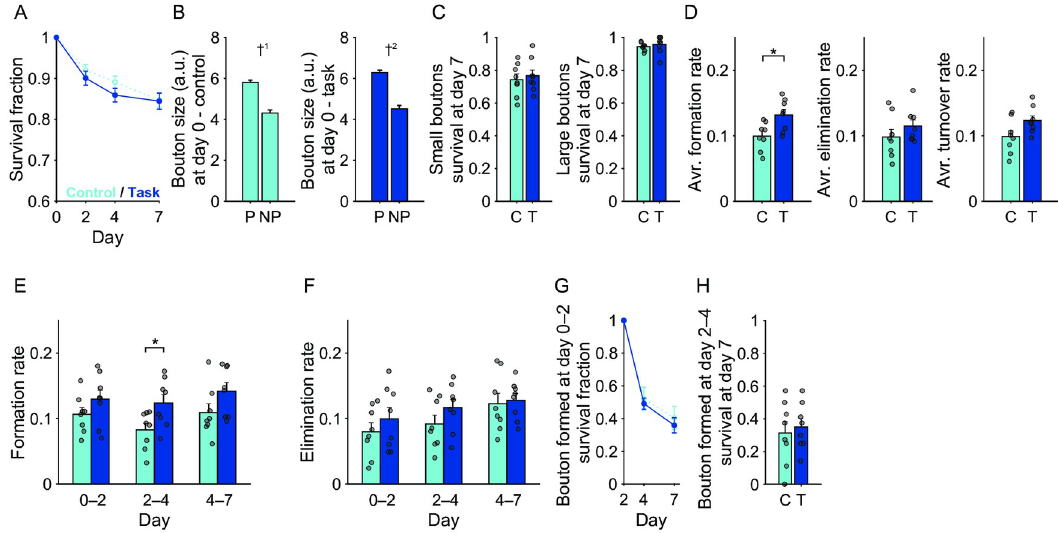
Fig 4. Dynamics and stabilization of M2 boutons during motor learning. (A) Survival fraction of the pre-existing M2 boutons up to day 7. Blue, M2 boutons in trained mice; cyan, M2 boutons in control mice. (B) The day 0 sizes of the pre-existing boutons that persisted until day 7 (P) and those that did not (NP). † 1 p < 1 × 10 − 8 , † 2 p < 1 × 10 − 9 . (C) Day 7 survival rates of small and large pre- existing boutons. Those pre-existing boutons whose sizes belonged to the lower and upper third were defined as small and large boutons, respectively. C, control mice; T, trained mice. (D) Averaged formation, elimination, and turnover rates over days 0–2, 2–4, and 4–7. � p < 0.05. (E) Formation rate of M2 boutons during days 0–2, 2–4, and 4–7. (F) Elimination rate of M2 boutons during days 0–2, 2–4, and 4–7. (G) Survival rate of the boutons that were newly formed during days 0–2. (H) Day 7 survival rates for those boutons that were newly formed during days 2–4. C, control mice; T, trained